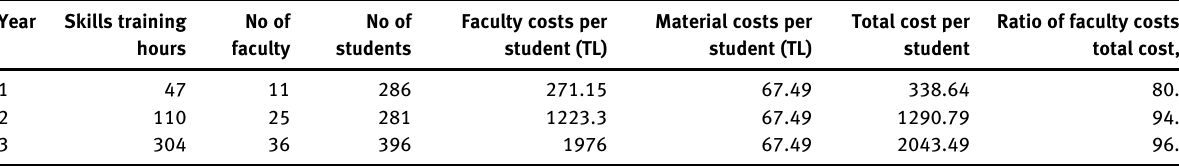
Table  : Faculty costs per